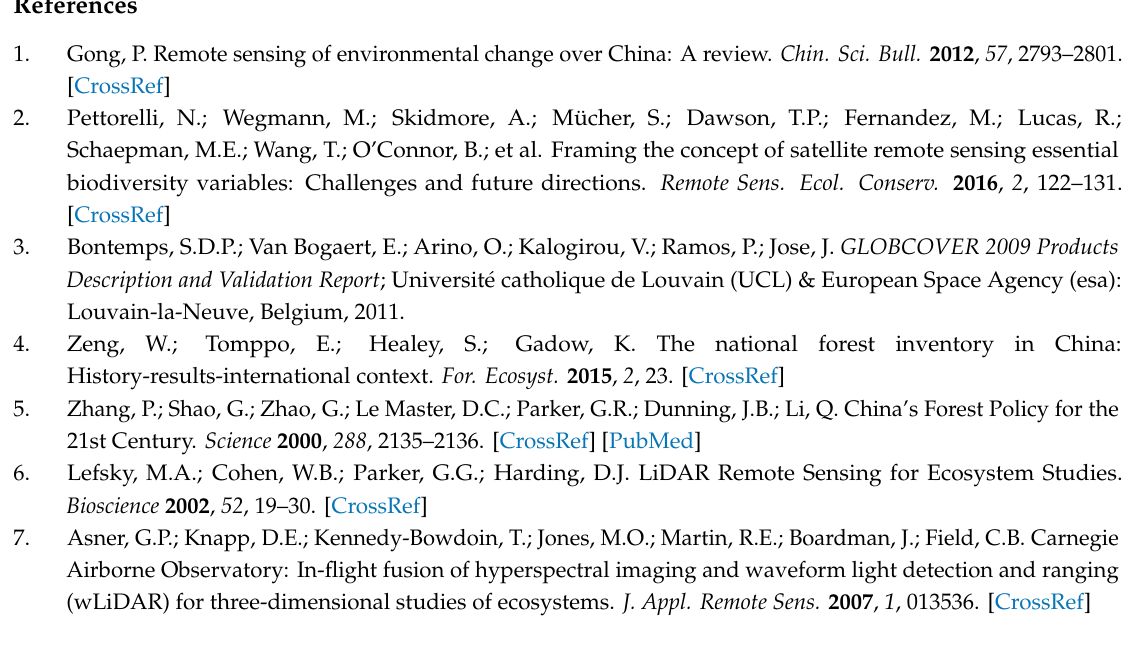
Table S1: List of the 50 ecozones in China, Table S2: The statistical information of forest height in 50 ecozones, Table S3: Abbreviations are used in this